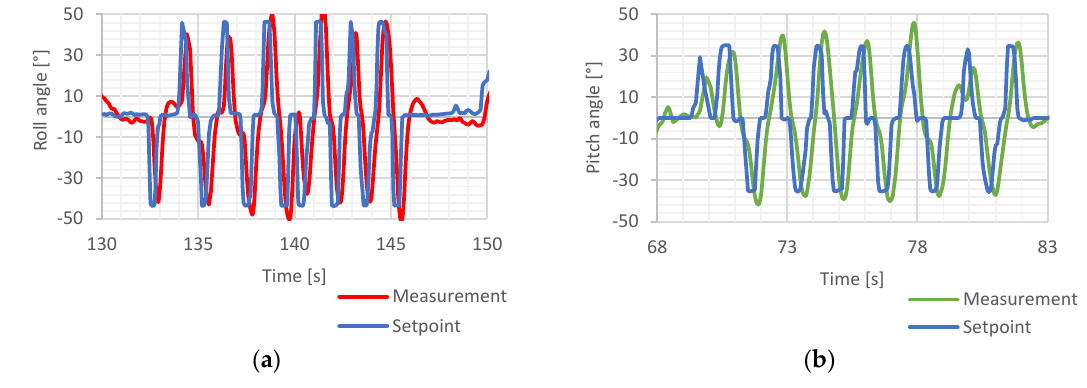
Figure 25. System response time test — 𝐾 𝑢 = 1.1 , ( a ) — roll axis, ( b ) — pitch axis [5].